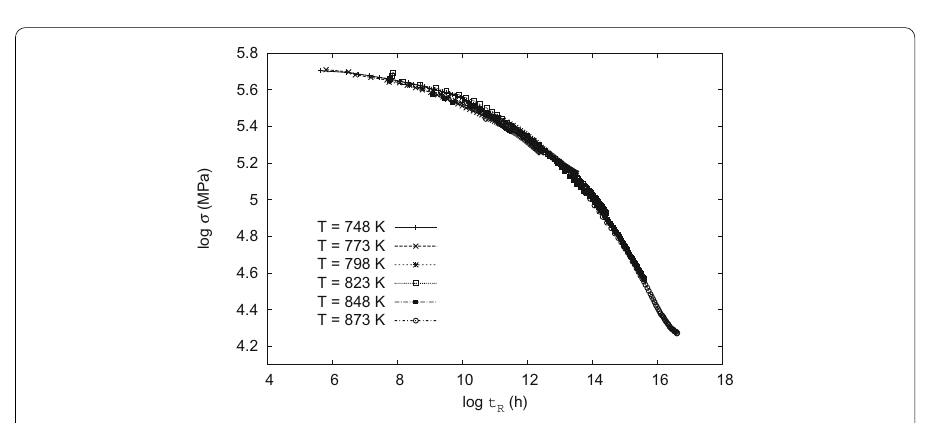
Fig. 5 Experimental master curve at the reference temperature ¯ T = 748K obtained by shifting the curves of Fig. 4 along the log t R and log σ axis (from Ref. [61])